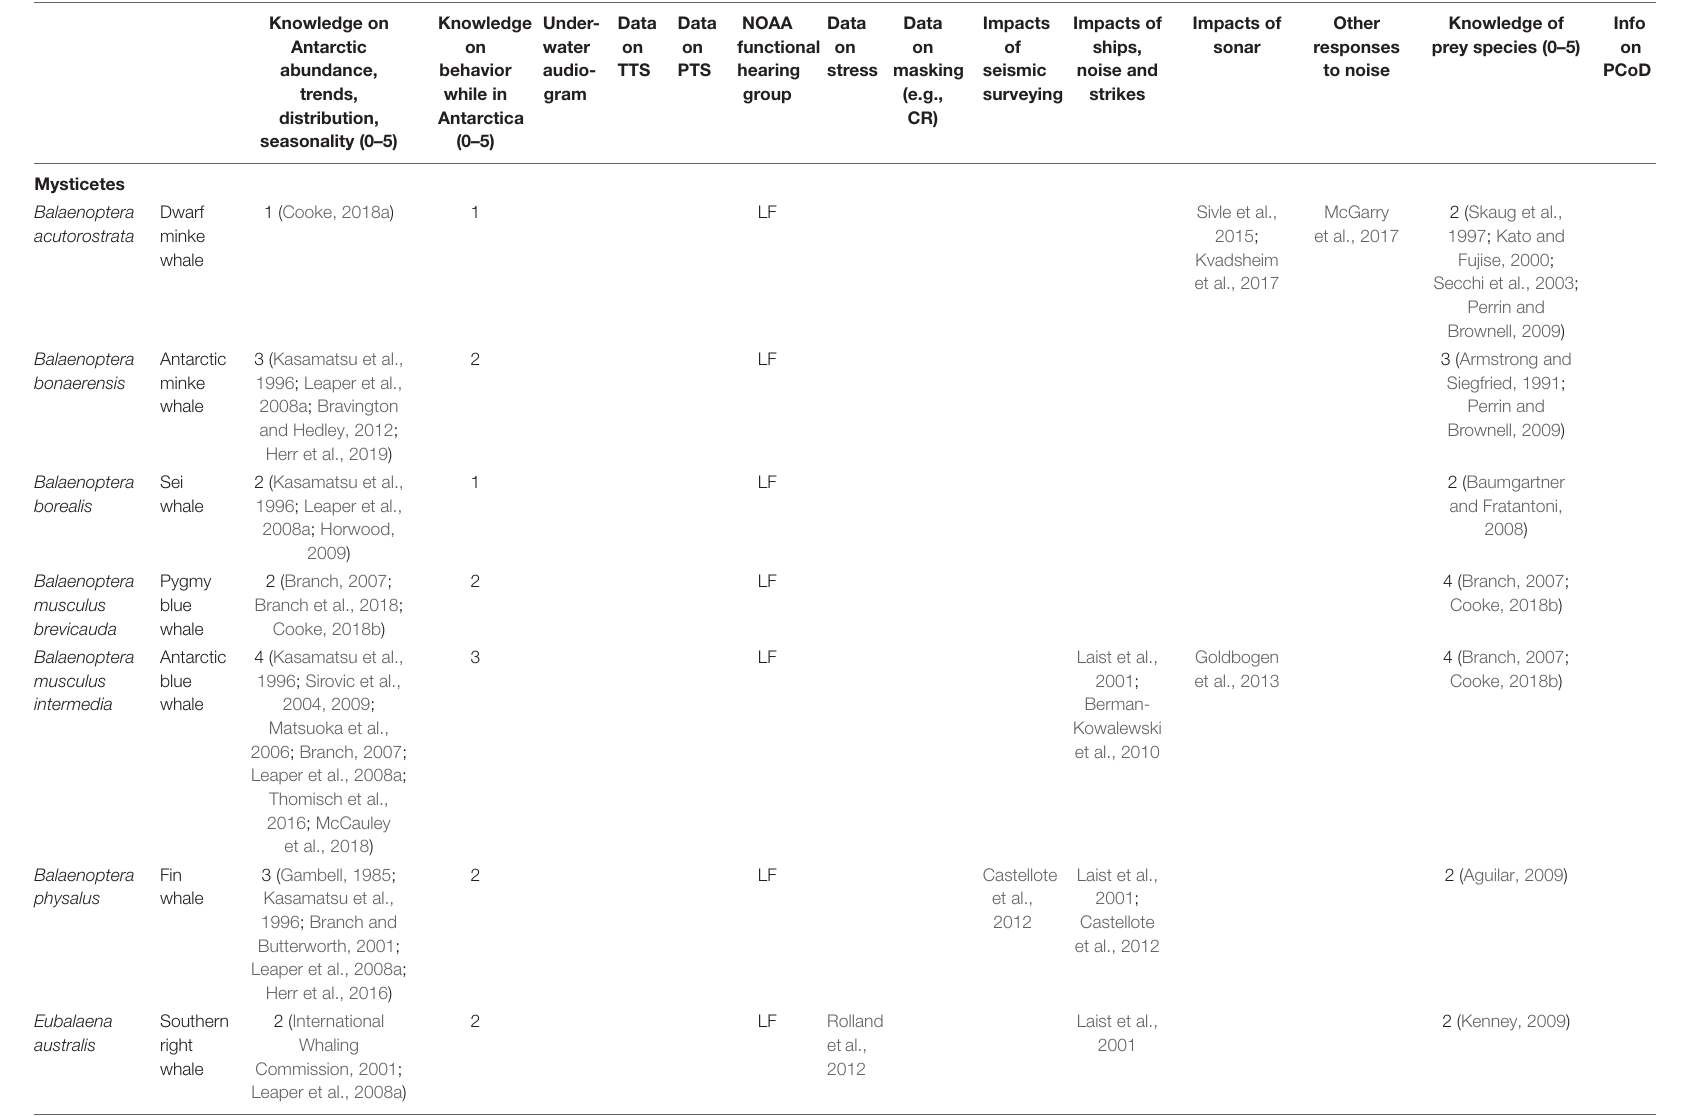
TABLE 2 | Available information and knowledge gaps regarding Antarctic marine